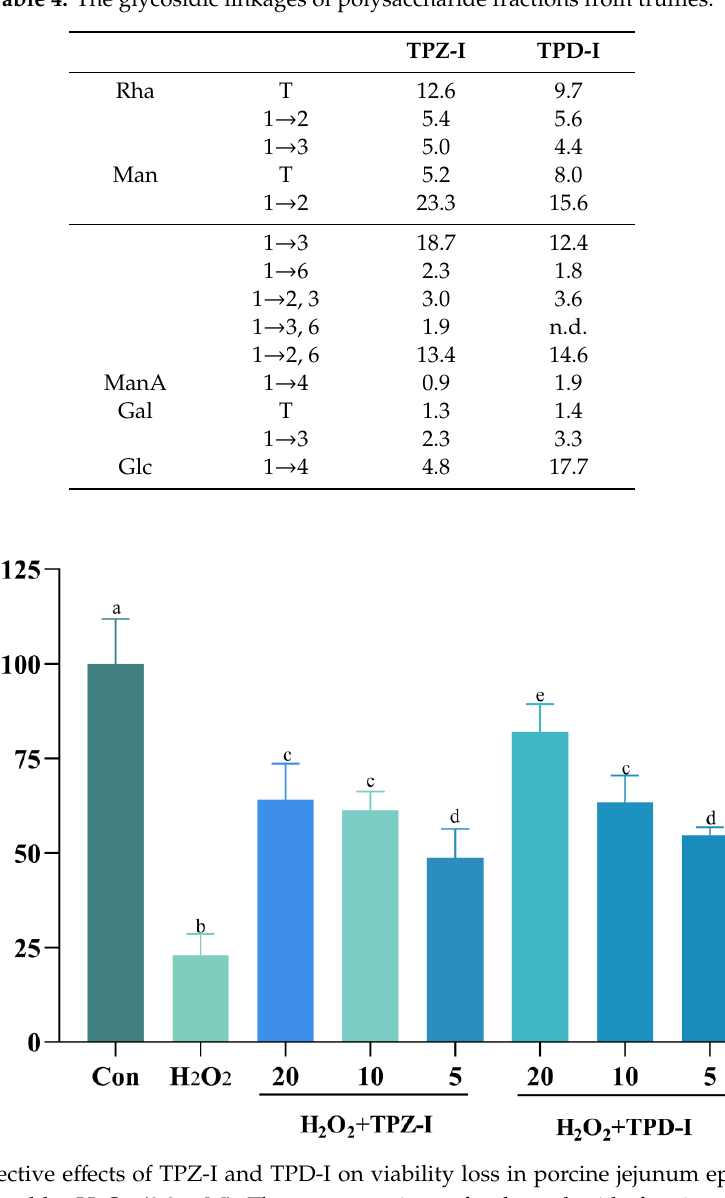
Table 4. The glycosidic linkages of polysaccharide fractions from tru ffl es.